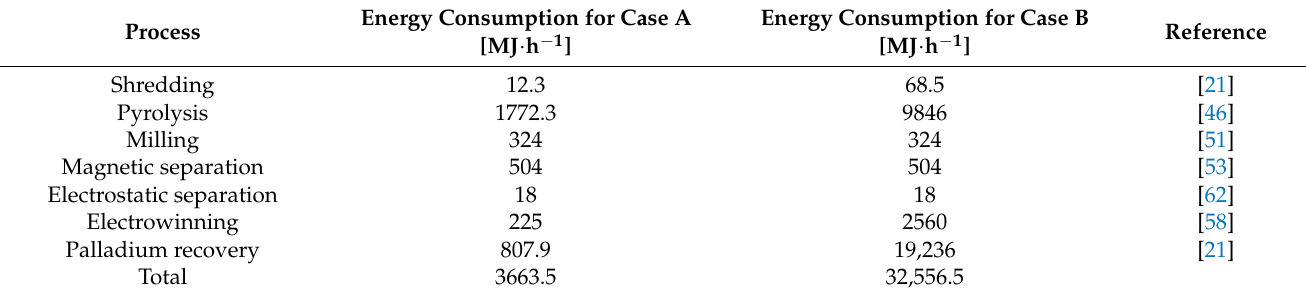
Table 4. Power consumption to process PCB for Case A and Case B.